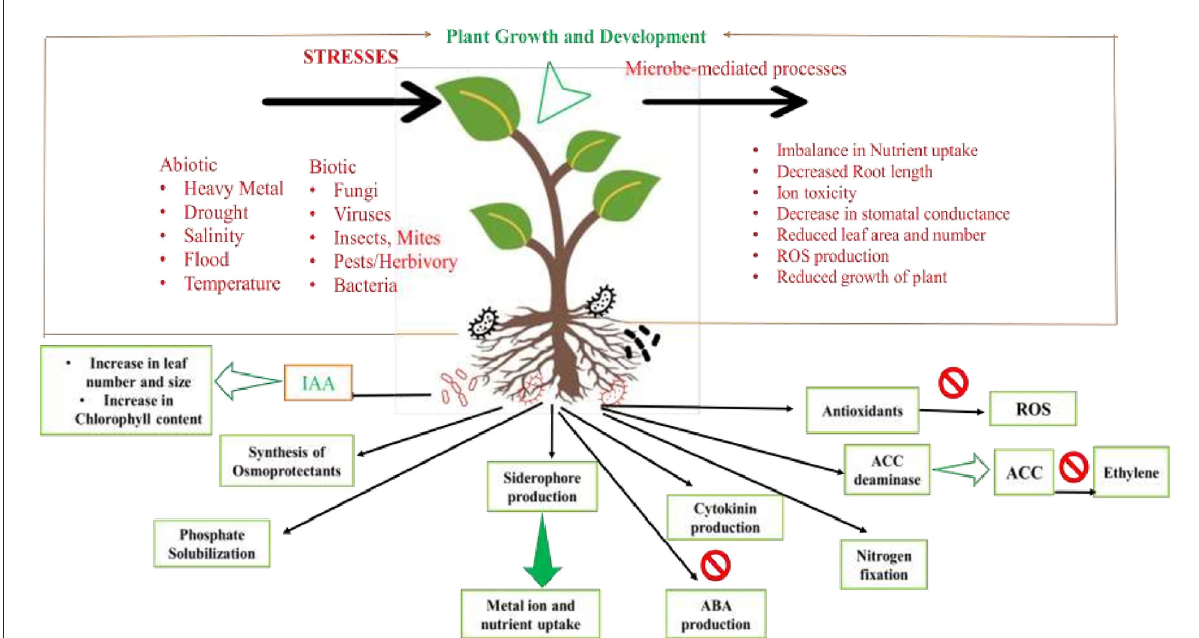
FIGURE1 Schematic representation of the microbial dynamics within soil during stresses. Microbes play an essential role in plant growth and development during adverse conditions through inducing defense signaling and stress-responsive processes in